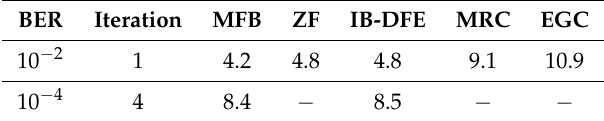
Table 1. E b / N 0 [dB] for the Bit Error Rate (BER) performance of the scenarios presented in [15]. BER Iteration MFB ZF